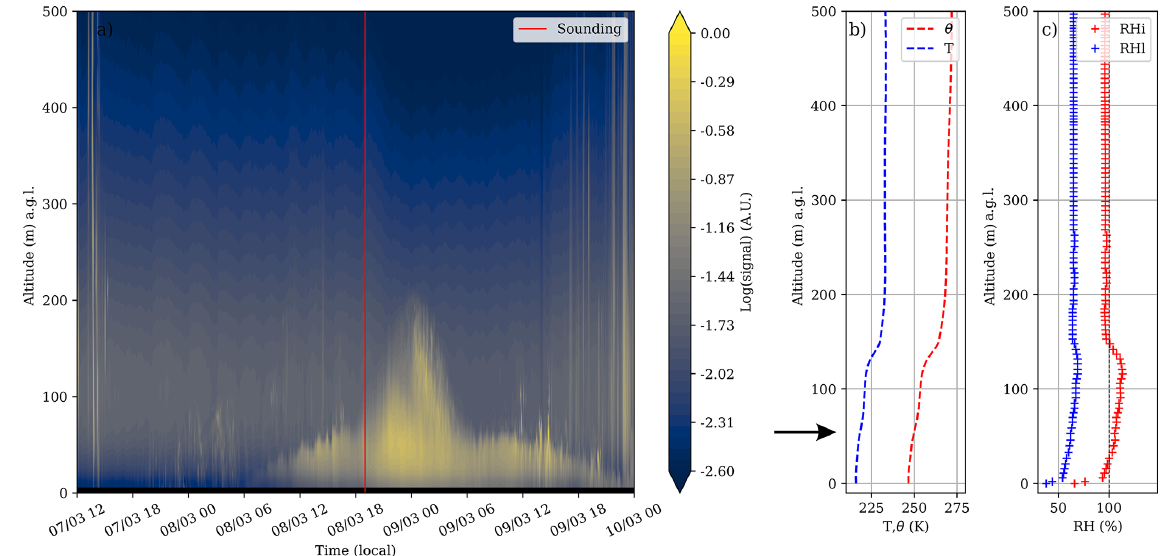
Figure 2. (a) Time–height plot of the lidar backscattering signal intensity during the first fog event between 12:00LT on 8 March to 00:00LT on 10 March 2018. The red line indicates the radiosonde launching time. Panel (b) shows the vertical profile of temperature (blue) and potential temperature (calculated with a reference pressure of 10 5 Pa, red) from the radiosounding. The black arrow indicates the top of the boundary layer. Panel (c) shows the vertical profile of relative humidity with respect to ice (RHi, red) and with respect to liquid water (RHl, blue) from the same radiosounding.